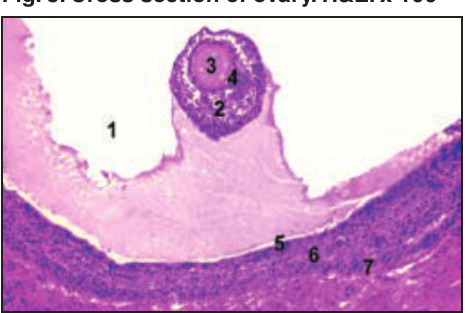
Fig. 3. cross section of ovary. h&E. x 100